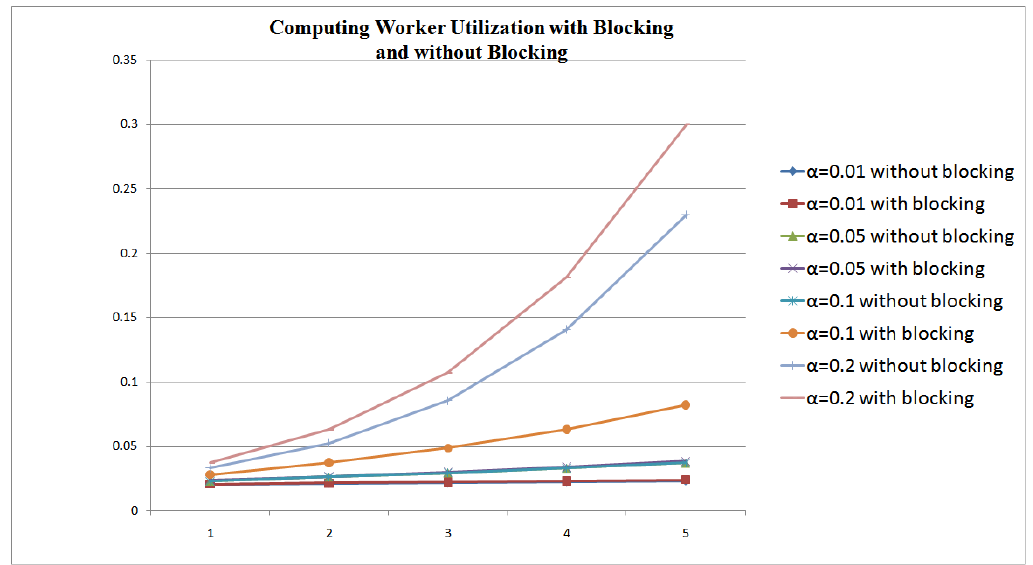
= (cid:22) = (cid:22) . 1 ;r 2 ;r 3 ;r